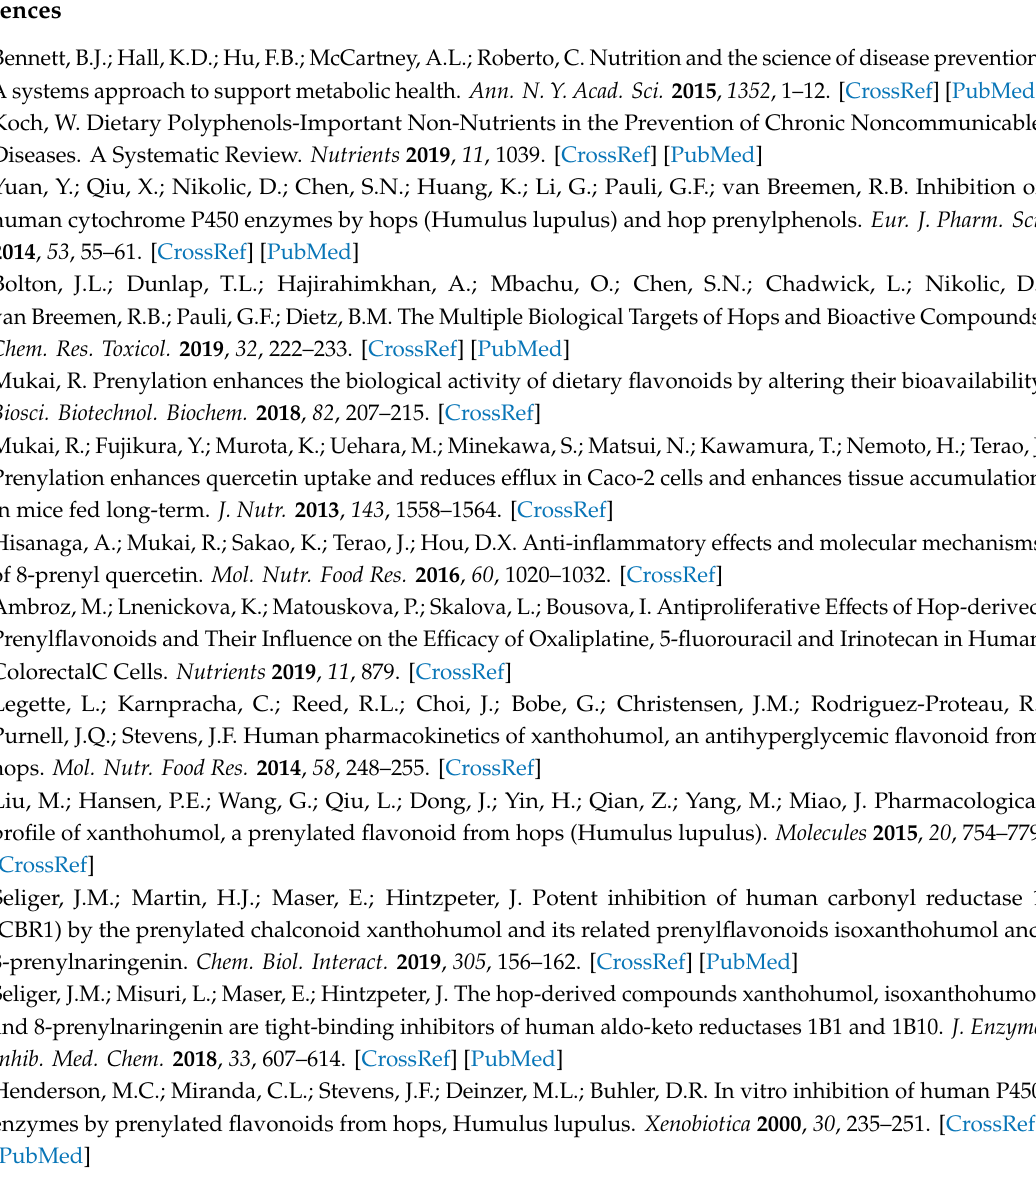
Figure S1: The e ff ect of prenylflavonoids (1 µ M) on the normalized mRNA expression of GSTA1 / 2, GSTP1, SULT1A3, COMT and UGT1A6 in proliferating and di ff erentiated CaCo-2 cells after 24 h and 72